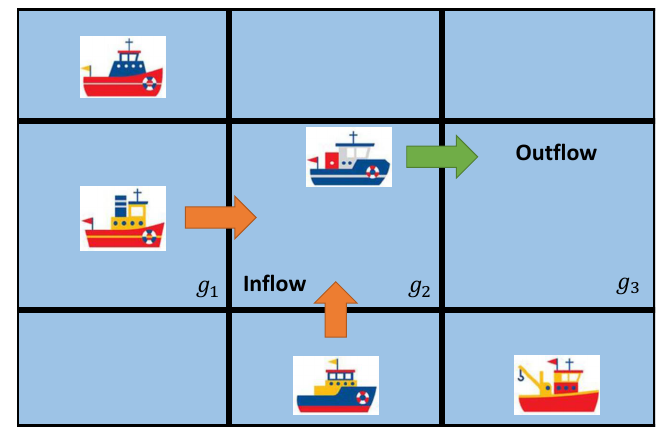
Figure 1. Illustration of the Inflow and